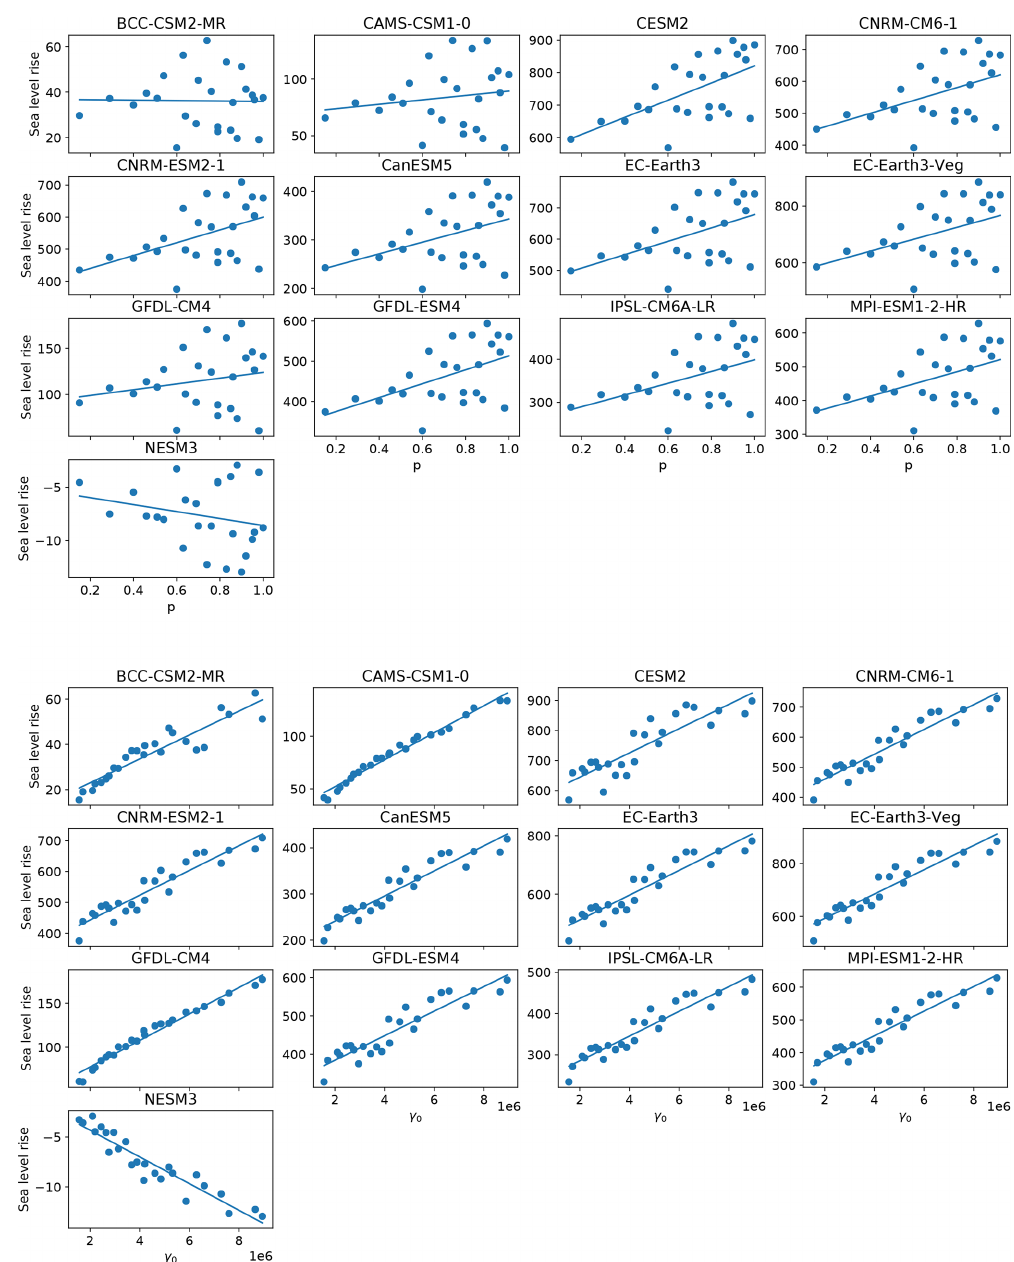
Figure A4. SLR as a function of p and γ 0 in the Weddell